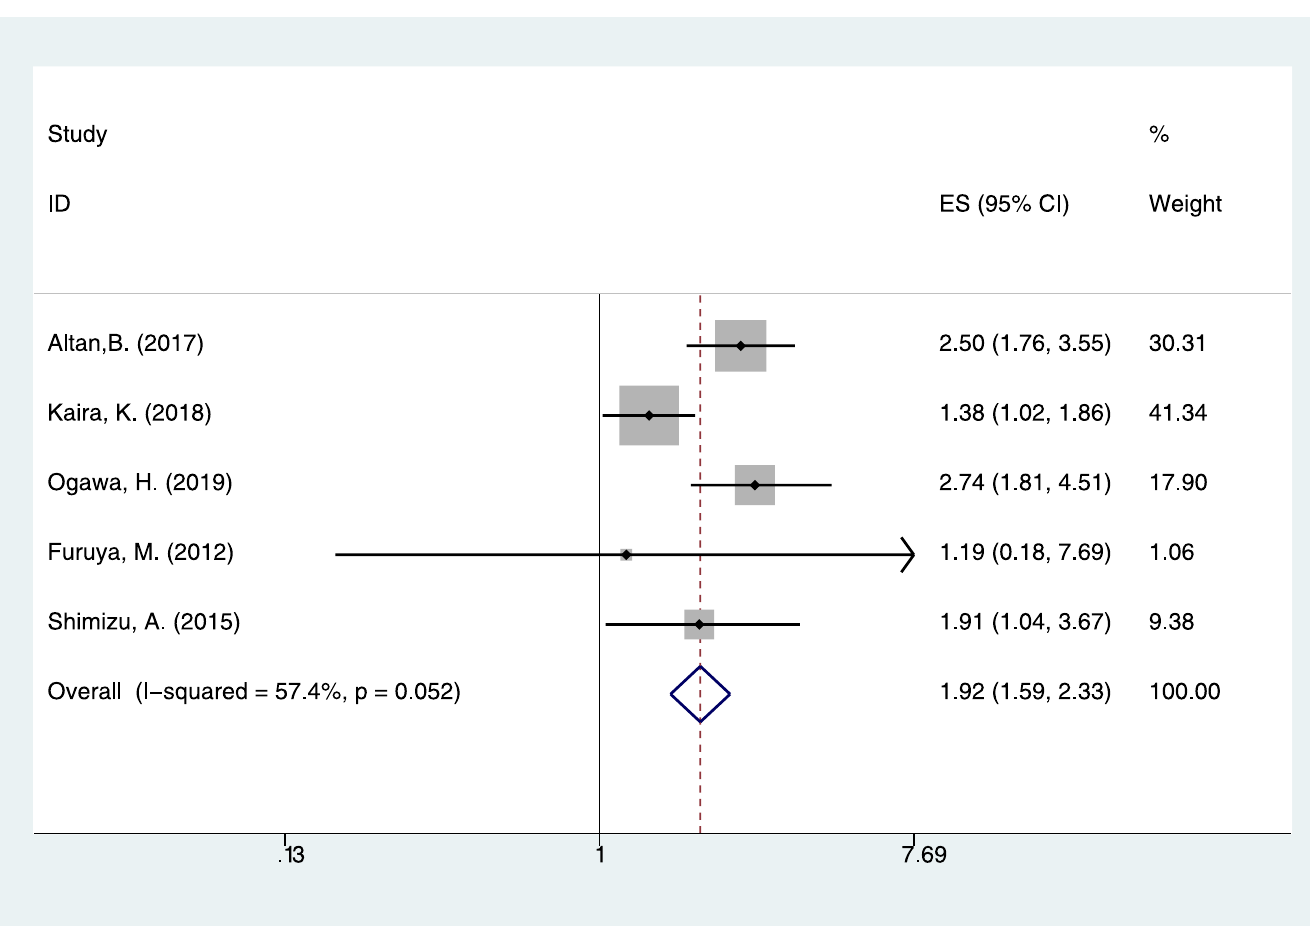
Fig 3. The correlation between LAT1 high expression and disease free survival